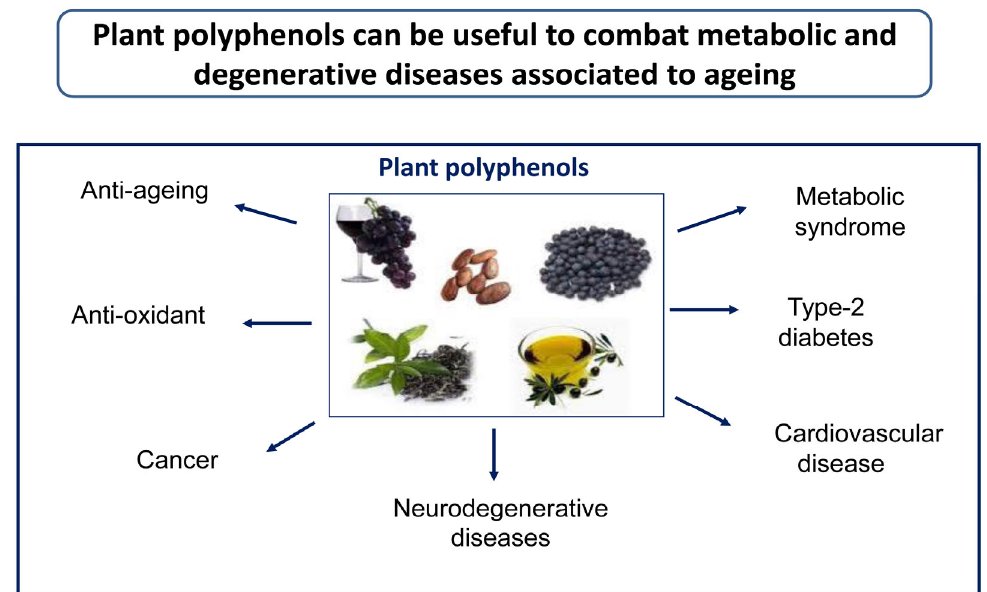
Figure 1. Plant polyphenols can be useful to prevent / combat a number of lifestyle-, metabolic-, and aging-associated pathologies.